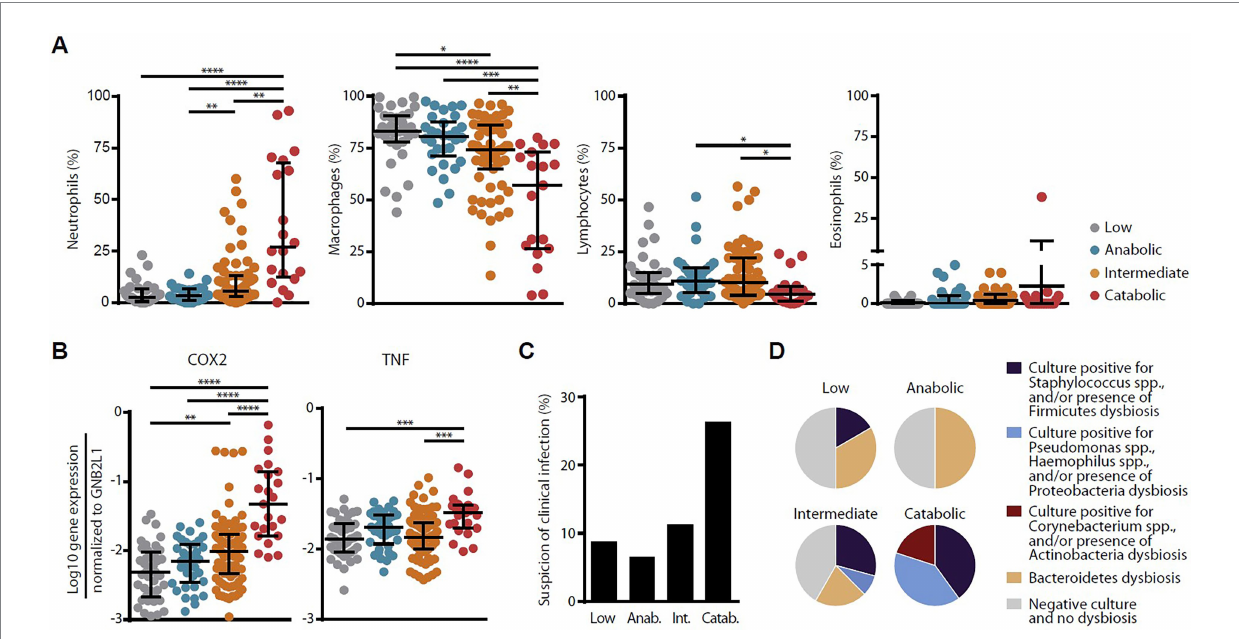
FIGURE 6 Associations among host remodeling, inflammation, and infection. Relationship among host remodeling and BAL cell differential (A) , expression of inflammatory genes COX2 and TNF-a (B) , the prevalence of suspected clinical infection (C) , and bacteria isolated by culture and/or driving dysbiosis (D) . In panels A and B, medians and IQRs are indicated. * p < 0.05, ** p < 0.01, *** p < 0.001, and **** p < 0.0001, adapted from (21).